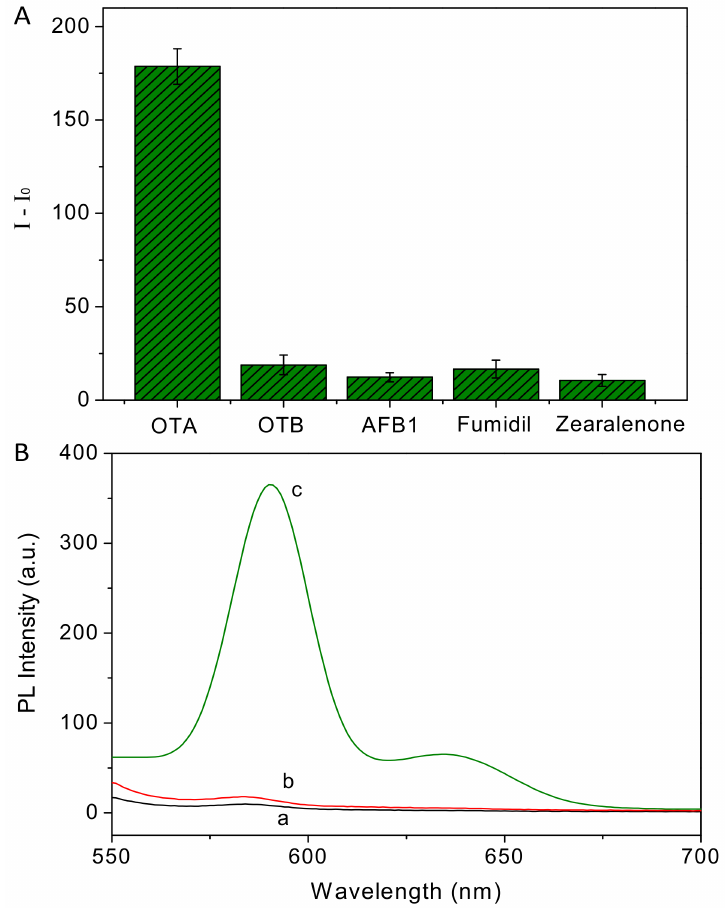
Figure 5. ( A ) Selectivity of the detection method to OTA over its analogues (the concentration of all mycotoxins are 1 nM); ( B ) emission spectra of ZnPPIX (a), ZnPPIX + cDNA + OTA (b), and ZnPPIX + aptamer + OTA